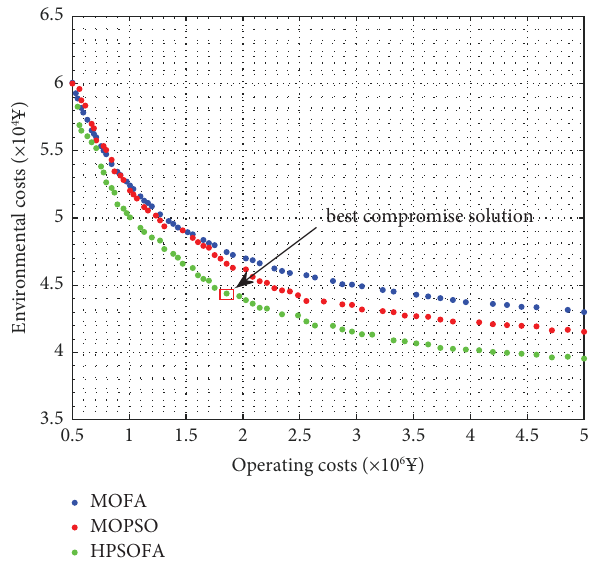
Figure 5: Pareto front in scenario 1.